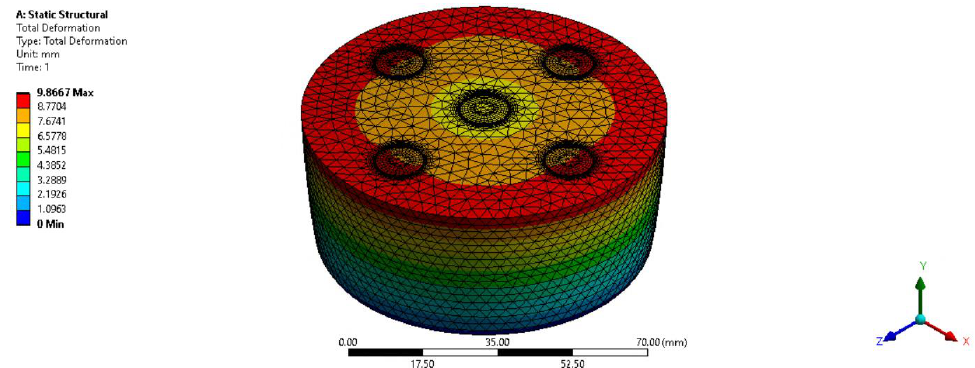
Figure 15. Deformation in the case of 5 large straws (to withstand a load of 2000 N).